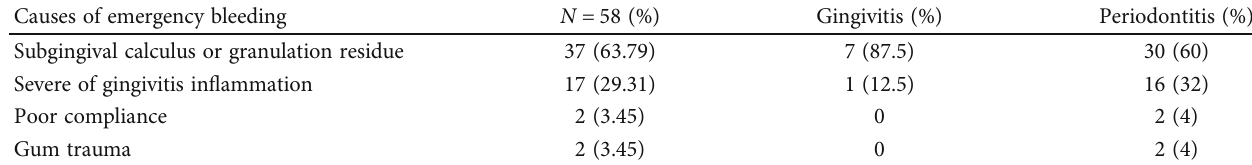
Table 2: Causes of emergency bleeding after nonsurgical periodontal therapy.